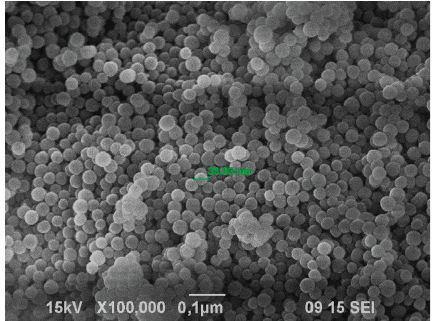
Figure 3: SEM micrograph of A-SiO